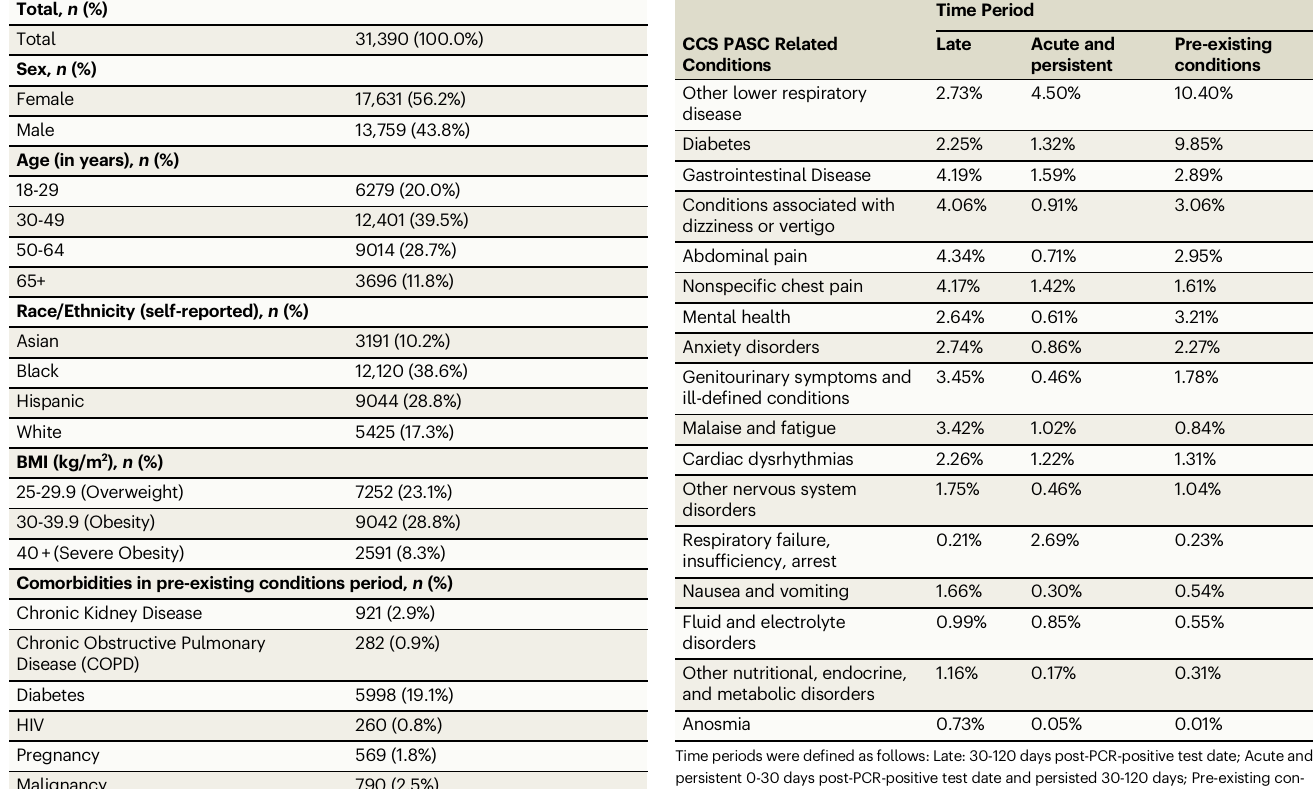
Table 1 | Positive SARS-CoV-2 RT-PCR patient demographics Category